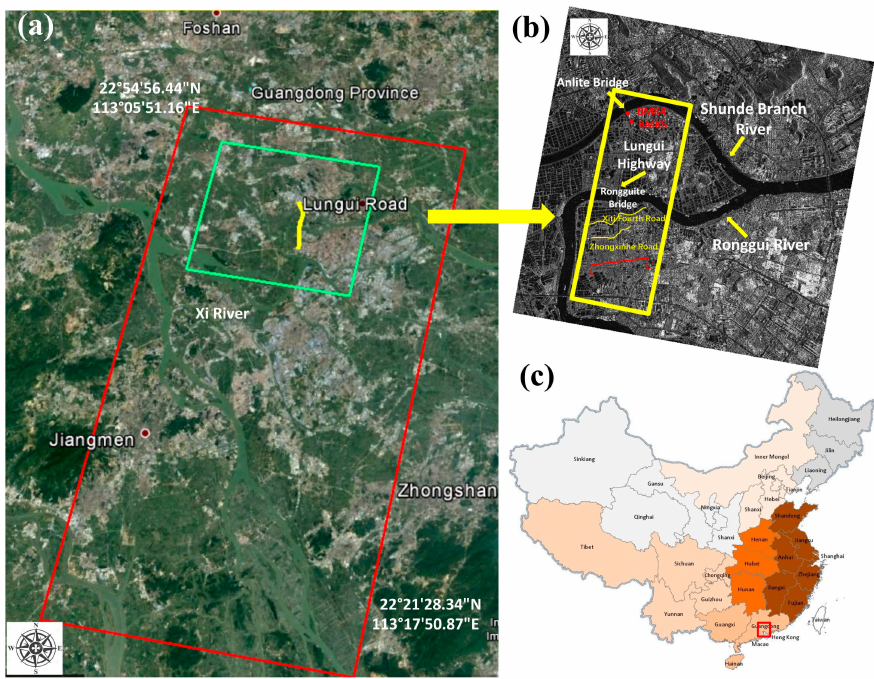
Figure 3. ( a ) Regional scale in China; ( b ) an amplified image of the area within the highway region of interest (outlined in the yellow rectangle); and ( c ) location of the study area in